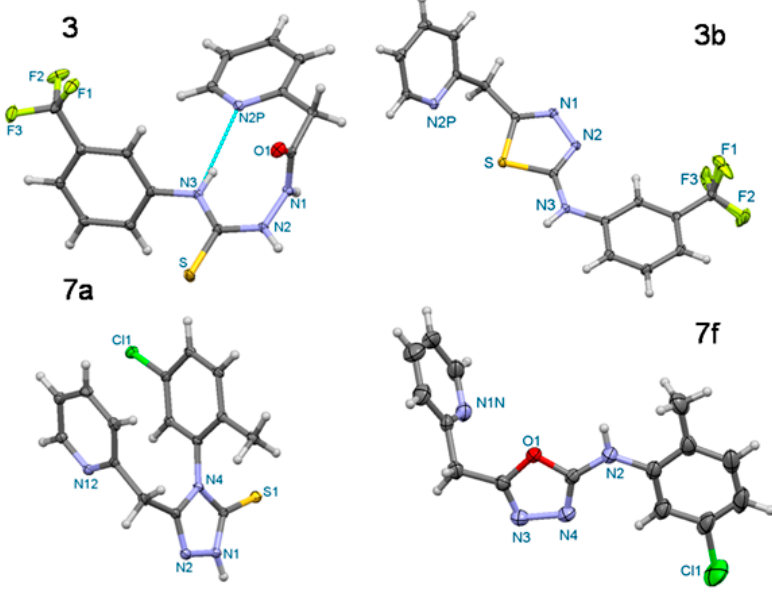
Figure 2. Perspective view of the molecular structures of the derivatives 2-(pyridin-2-yl-acetyl)- N -[3-(trifluoromethyl)phenyl]hydrazinecarbothioamide ( 3 ), 5-(pyridin-2-yl-methyl)- N -[3-(trifluoromethyl)phenyl]-1,3,4-thiadiazol-2-amine ( 3b ), 4-(5-chloro-2-methylphenyl)-5-(pyridin-2-yl-methyl)-2,4-dihydro-3 H -1,2,4-triazole-3-thione ( 7a ) and N -(2-chloro-5-methylphenyl)-5-(pyridin-2-ylmethyl)-1,3,4-oxadiazol-2-amine ( 7f ).